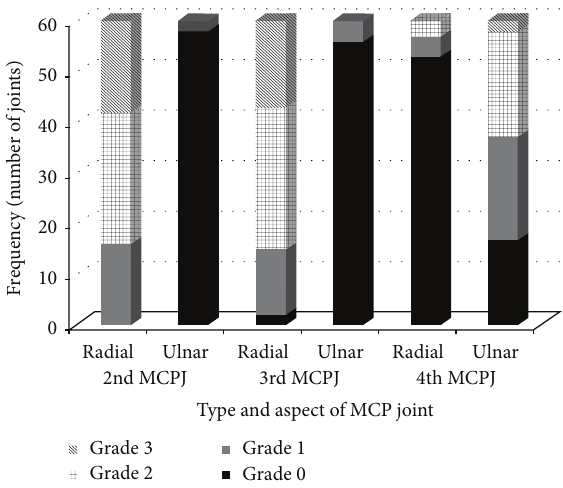
Figure 3: Distribution of grades of synovitis in the radial and ulnar sides of the 2nd, 3rd and 4th MCPJ of both hands in RA